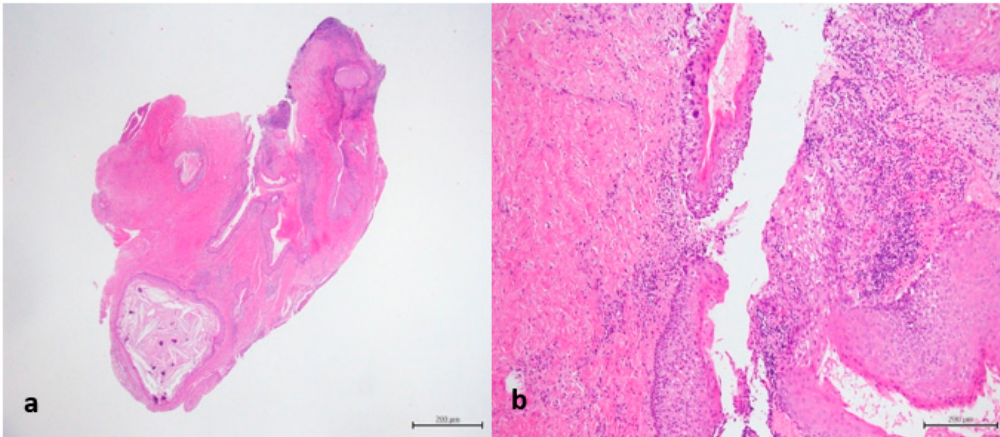
Figure 5. ( a ) Dentigerous cyst lined by epithelium (H&E staining, 12.5 × magnification); ( b ) In detail transition between normal epithelium and carcinoma in situ (H&E staining, 100× magnification).